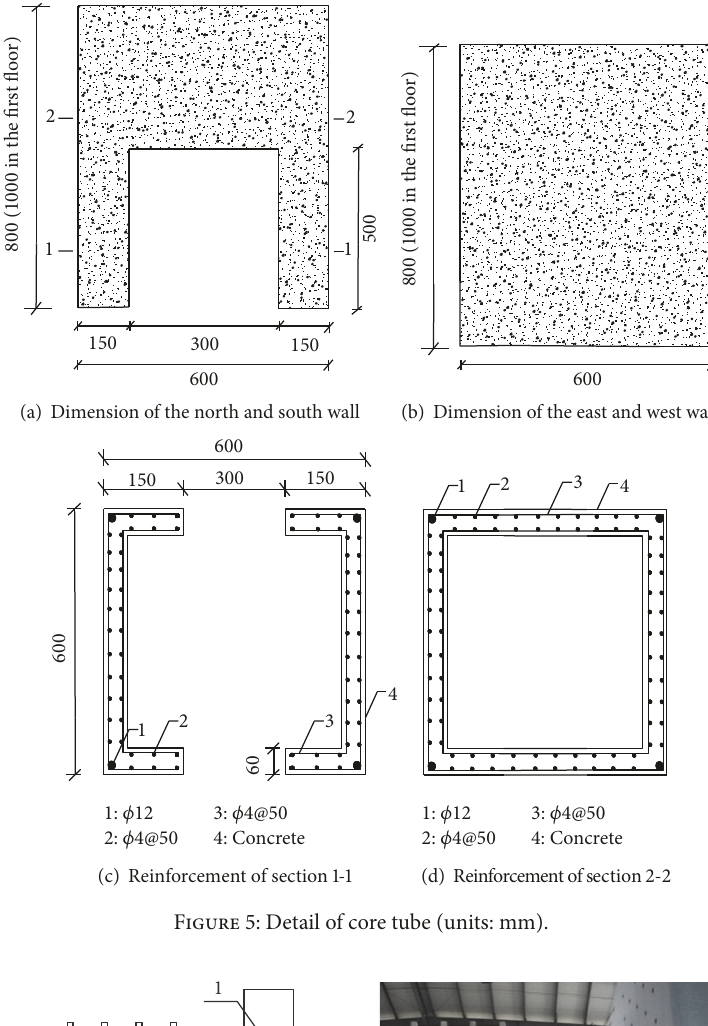
Figure 5: Detail of core tube (units: mm).